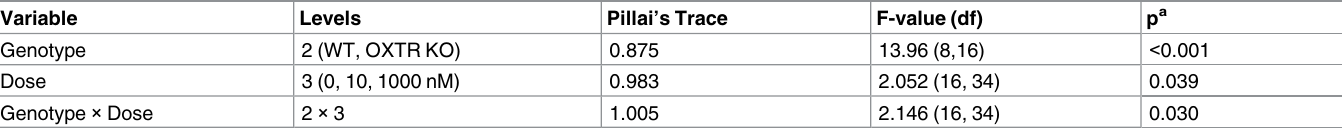
Table 1. Multivariate test (MANOVA).